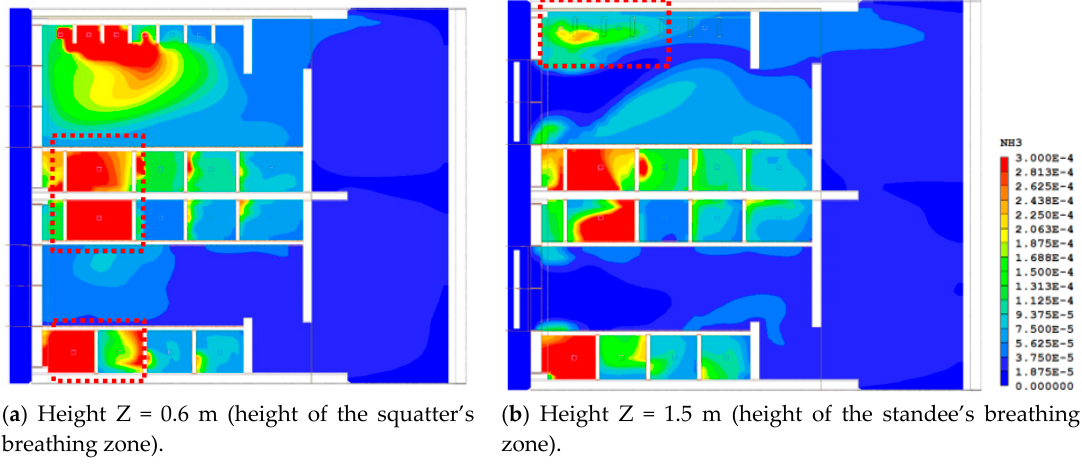
Figure 6. NH 3 concentration (PPMV) distributions at breathing zone heights for ( a ) squatting position and ( b ) standing position in north wind (window configuration: W2; the opening angle θ is 45 ◦ ; the outdoor wind speed is 1 m / s).